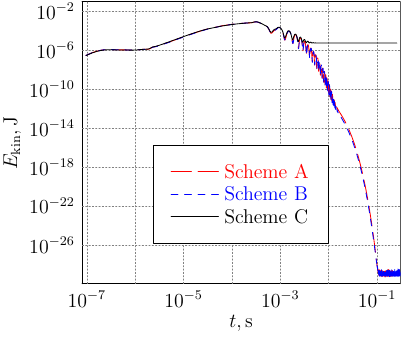
Figure 2. Problem 3.1: plots of E tot ( t ) for the schemes for λ 1 = 6